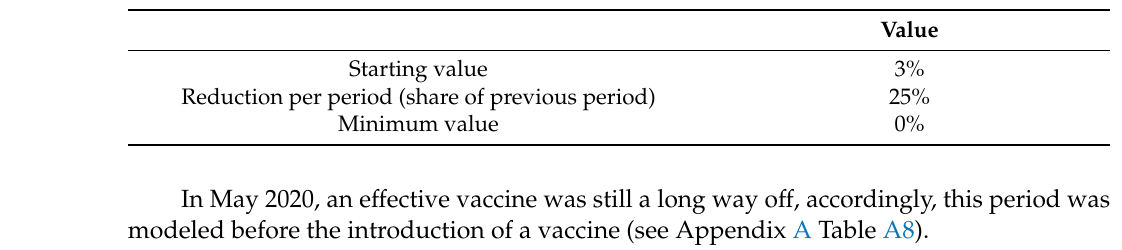
Table A7. Estimation of unreported cases.